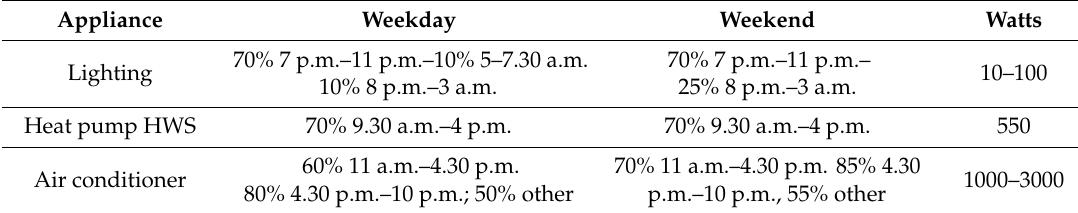
Table 4. Major load variations in winter.